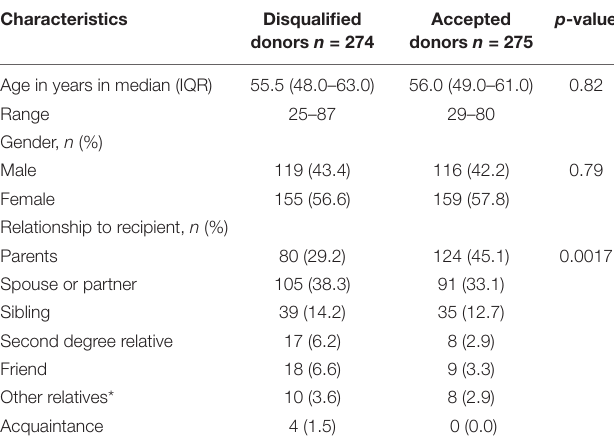
TABLE 3 | General characteristics of disqualified donors and donors completing the LKD